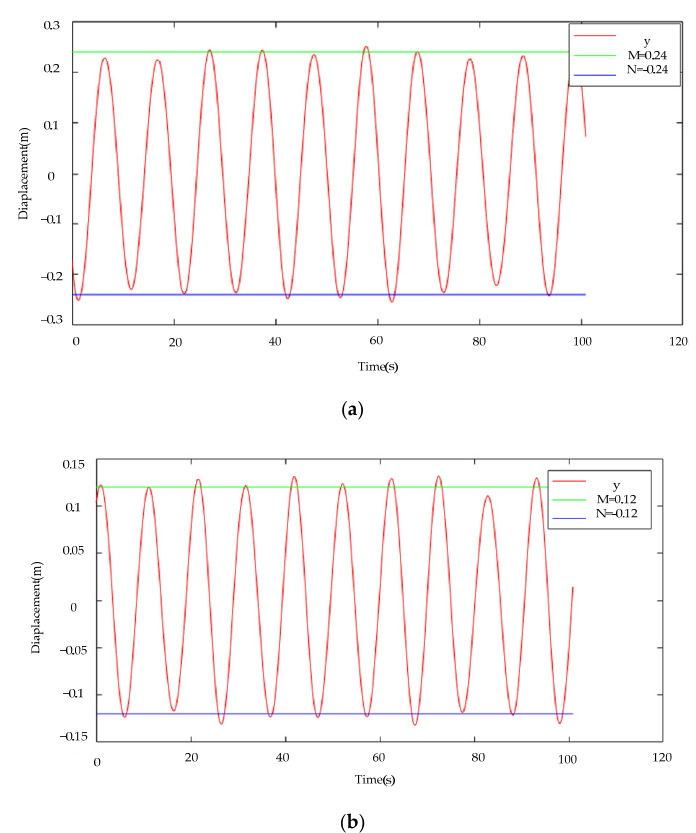
Figure 16. Galloping amplitude curve ( a ) x -axis displacement ( b ) y -axis displacement.